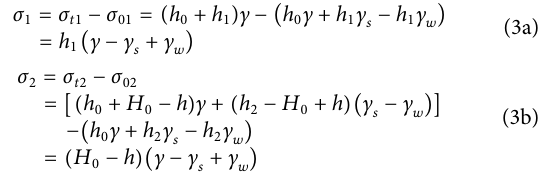
FIGURE 5 Timoshenko beam deformation